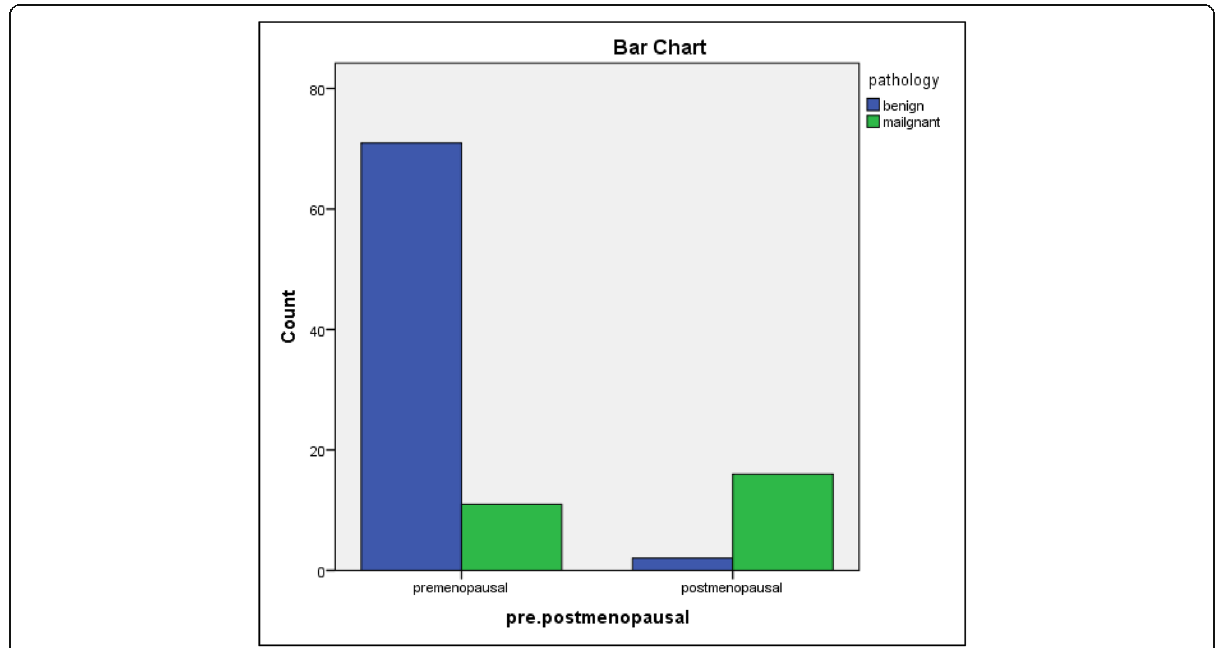
Fig. 2 Correlation between age whether pre- or postmenopausal and the pathology of the lesions